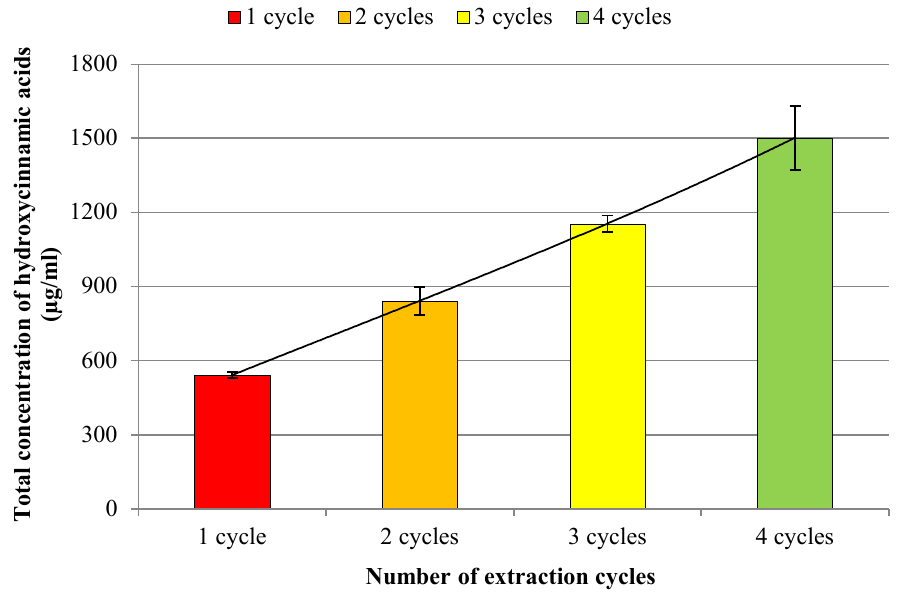
Figure 3. The effect of the number of extraction cycles on total concentration of hydroxycinnamic acids.